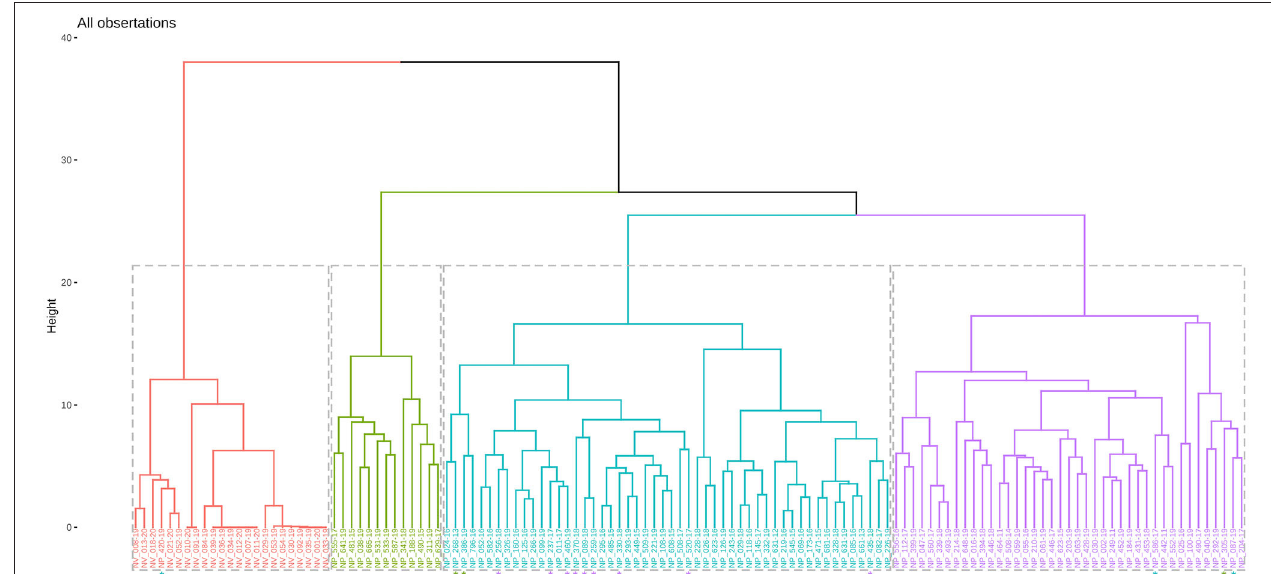
FIGURE 1 | Dendrogram of hierarchical cluster analysis. Violet tree resembles cluster 1, turquoise tree cluster 2, green cluster 3, and orange cluster 4. Manual correction of single animals are shown with an asterisk ( * ) in the color of the final cluster.